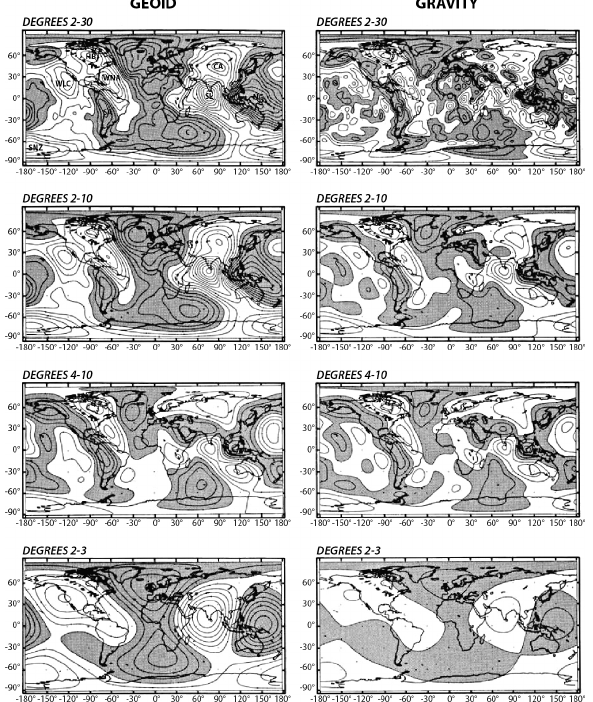
Figure 4. Geoid and gravity anomaly maps from GEM-L2 spher- ical harmonic coefficients. Referenced to ellipsoid with reciprocal flattening of 298.257 (actual Earth flattening). Contour intervals are 10m and 20mGal, respectively. Degree 2–30 maps obtained by summing contributions from degrees 2 through 30. Degree 2–10, 4–10, and 2–3 maps similarly obtained. In the geoid degree 2–30 map (and in Fig. 2) the 10 major anomalies are labeled, and identi- fied in Fig. 3.